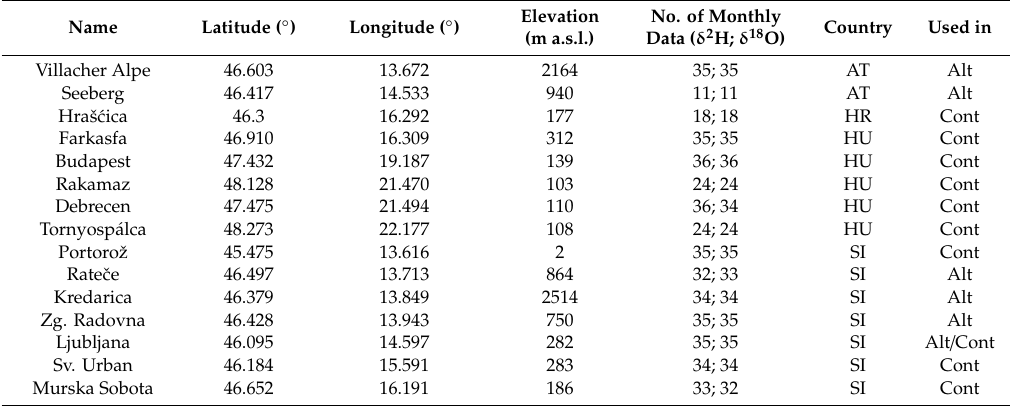
Table 1. Basic geographical information of precipitation stable isotope monitoring stations operating in East-Central Europe between January 2016 and December 2018. Country codes follow the ISO-3166-1 ALPHA-2 standard. Latitude and longitude are in WGS84 projection; EPSG: